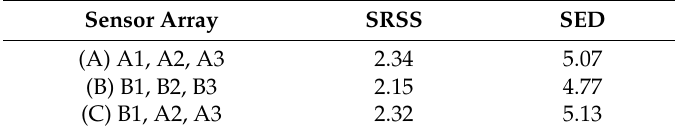
Figure 9. Normalized response pattern of sensor channels. Table 5. SRSS and SED comparison of sensor arrays consisting of different channels.